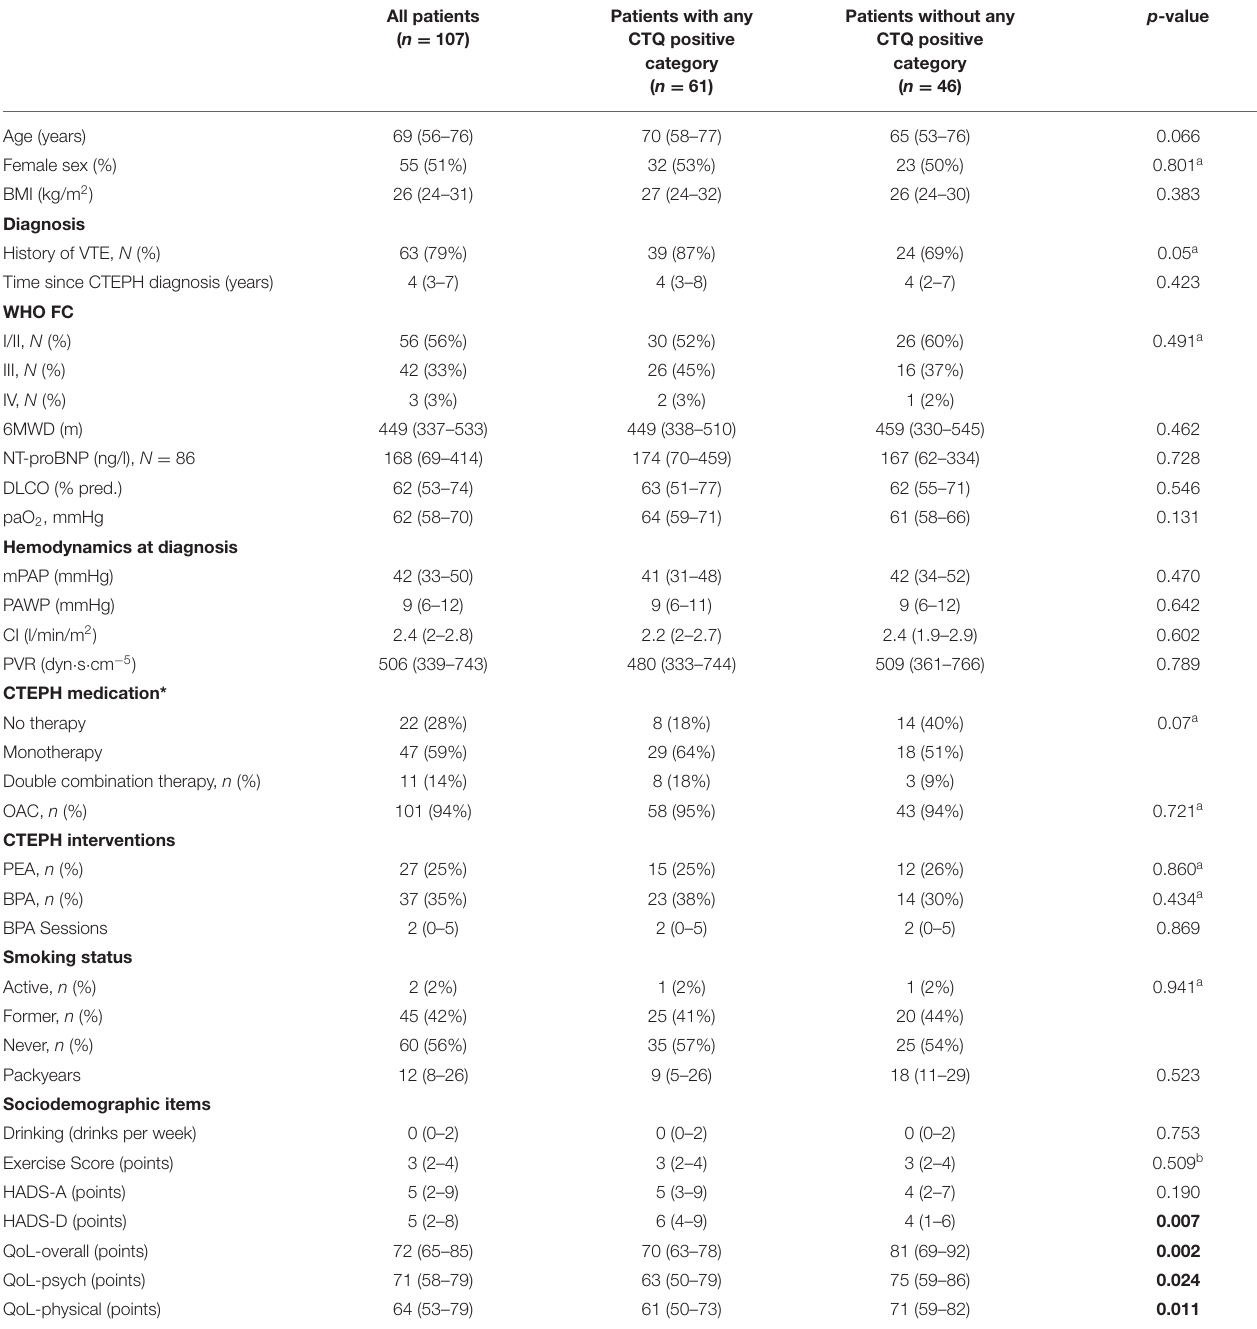
TABLE 1 | Characteristics of the patients at baseline.